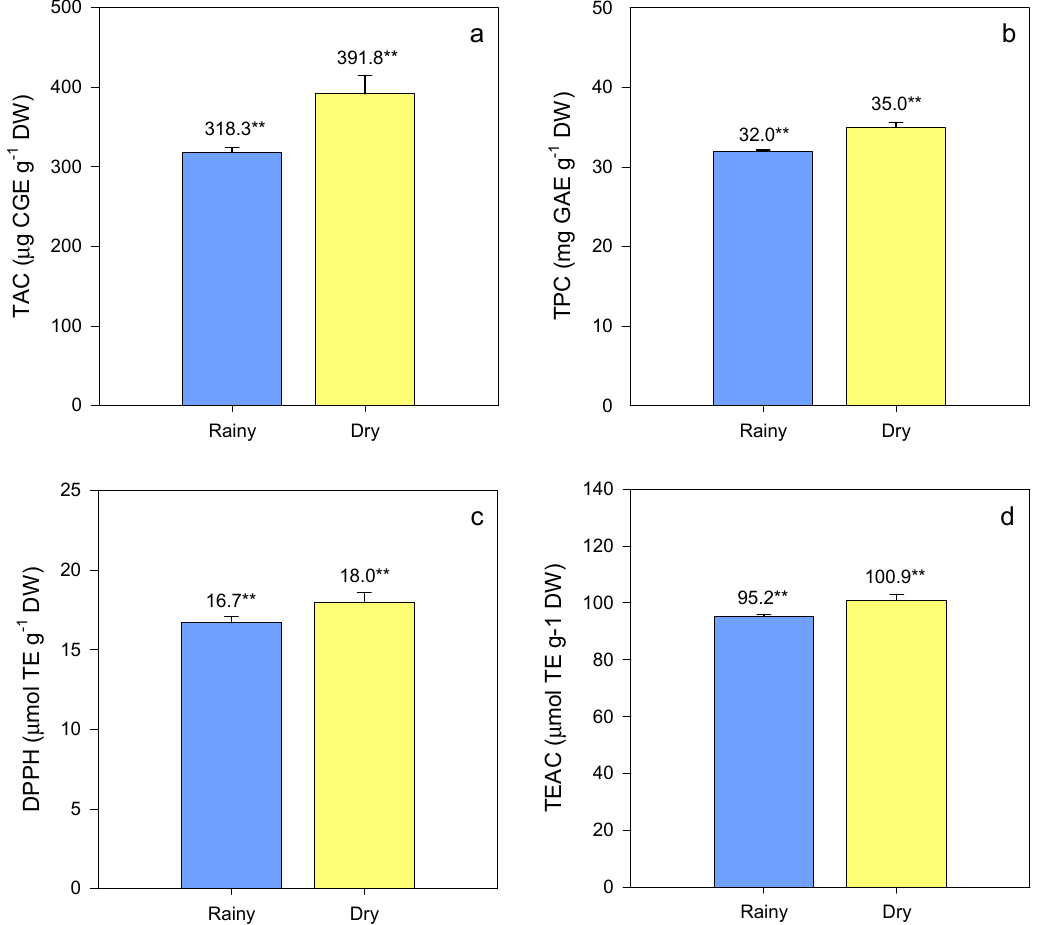
Figure 1. Means for ( a ) the total anthocyanin content (TAC), ( b ) total phenolic content (TPC), ( c ) DPPH radical scavenging activity (DPPH) and ( d ) Trolox equivalent antioxidant capacity (TEAC) in the tassel of waxy corn genotypes evaluated in the rainy season 2017 and dry season 2017/2018. ** significant difference at p ≤ 0.01 by the least significant difference (LSD). Data are expressed as the mean ± SD.